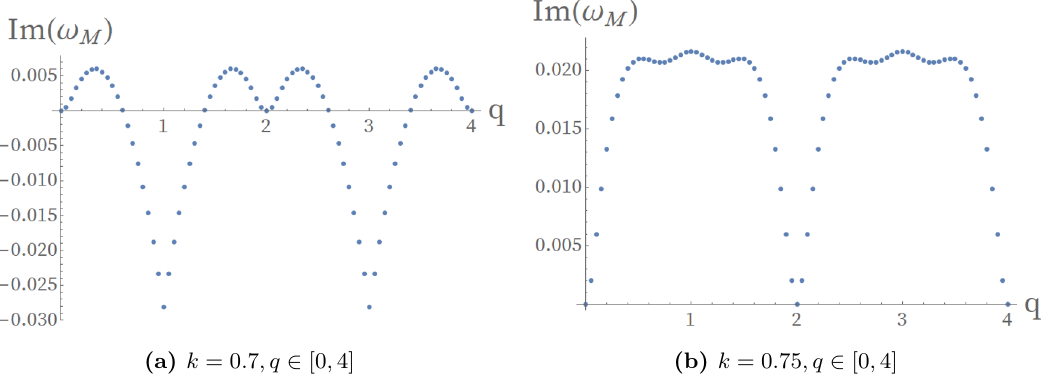
Figure 4. Im( ω M ) as a function of q when Bloch wave vector k = 0 . 7 , 0 . 75